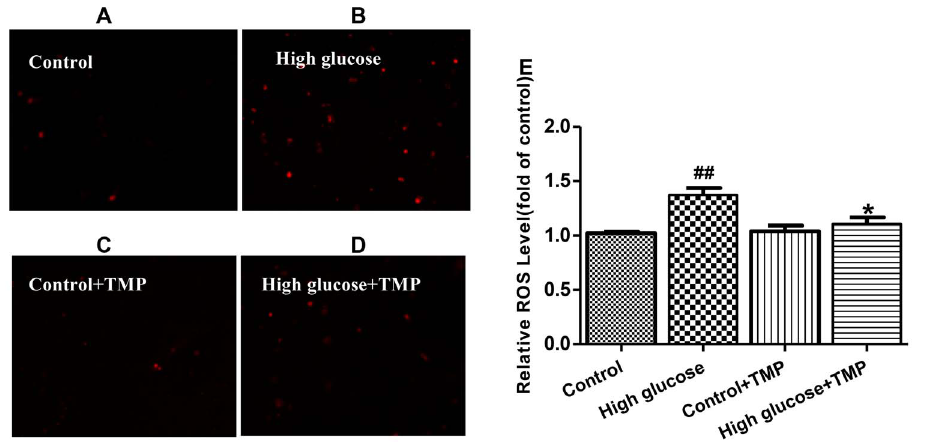
Figure 4. TMP decreased superoxide anions in high glucose-treated endothelial cells. Superoxide anions were detected in HUVEC treated with ( A ) 5.6 mmol/L glucose (Control), ( B ) High glucose (30 mmol/L), ( C ) Control + TMP (30 m mol/L) and ( D ) High glucose + TMP (30 m mol/L) by using MitoSOX TM Red. Fluorescence intensity was recorded by fluorescence microscopy, and the quantification data are shown ( E ). Data are mean 6 SEM (n=4). ## P , 0.01 vs. Control; * P , 0.05 vs. High